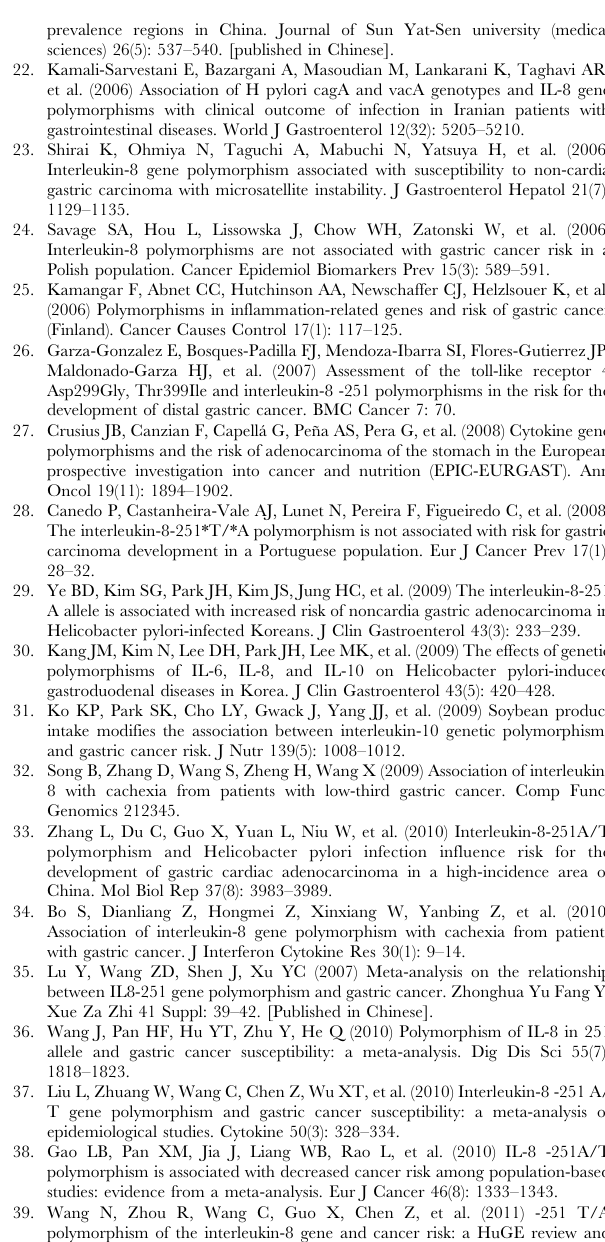
Table S1 Scales for Quality